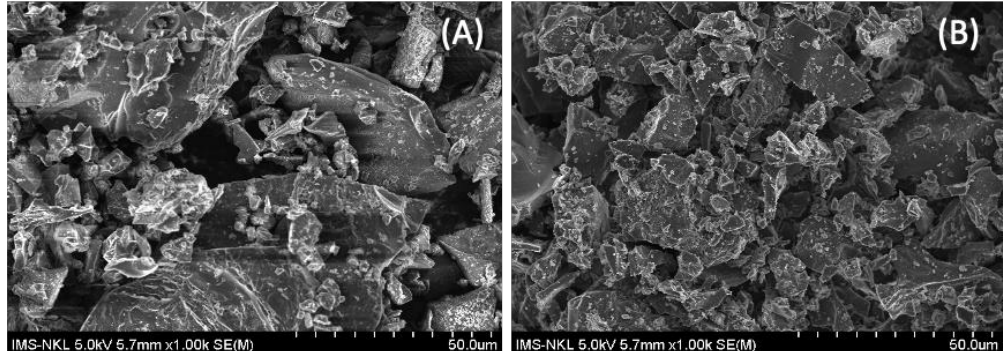
Figure 2. SEM image of activated carbon DS ( A ) activated carbon ACDS ( B ).